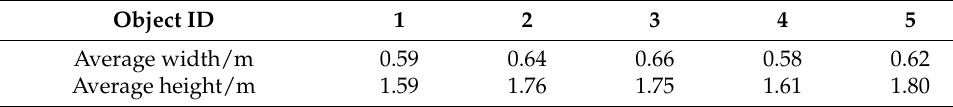
Figure 12. The height of moving objects. ( a ) The original calculation results of the object height; ( b ) the calculation results of the object height filtered by median filtering. The ordinate is the height (m), and the abscissa is the video frame number. Table 2. Average width and height of moving objects.